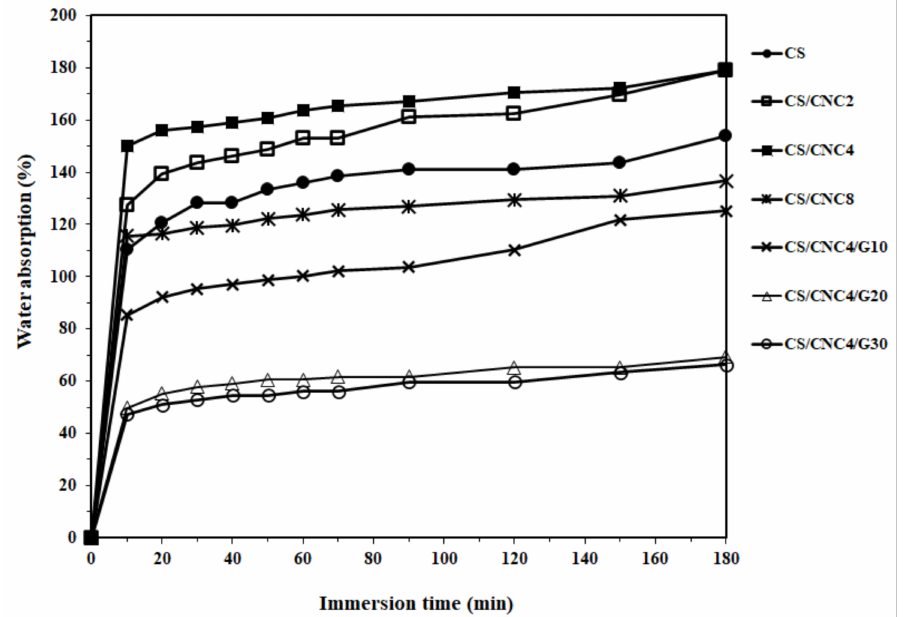
Figure 6. Water absorption curves of chitosan and its bio-composite films at various CNC and glycerol